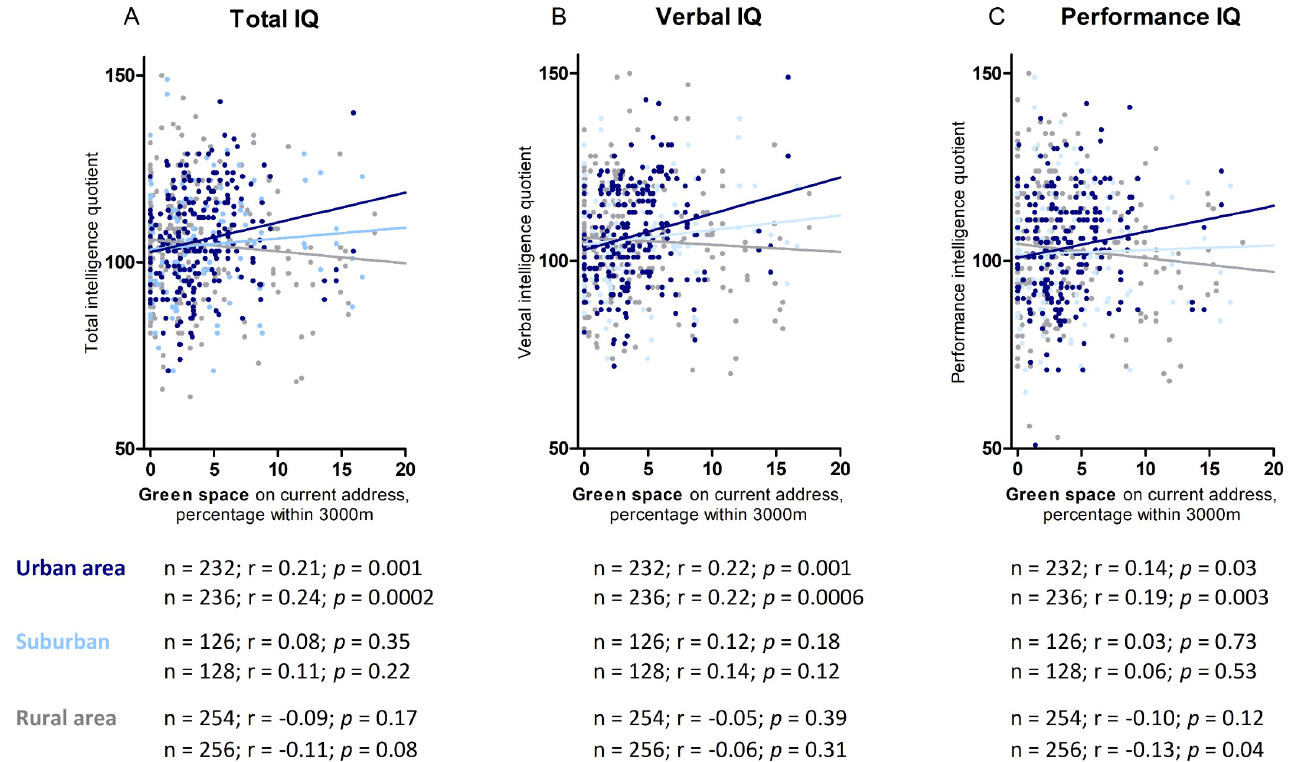
Fig 1. The association between intelligence and residential green space is modified by the degree of urbanicity ( p for interaction < 0.001). Intelligence is shown in association with green space in a 3,000-m radius around the current residence in twins living in an urban ( n = 232), suburban ( n = 126), and a rural area ( n = 254). Data points ( n = 8) with green space > 20% were excluded from the figure for visibility of the figure. (A) Total IQ, (B) verbal IQ, and (C) performance IQ. Correlation coefficients are shown for data points in figure (excluding points with green space > 20%) and for all data points. IQ, intelligence